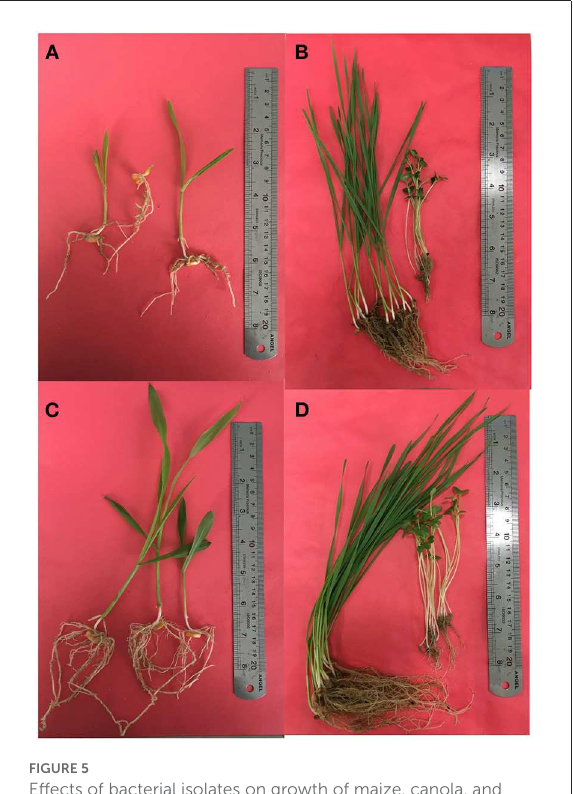
FIGURE5 Effects of bacterial isolates on growth of maize, canola, and wheat (C,D) in comparison with the uninoculated control condition (A,B)